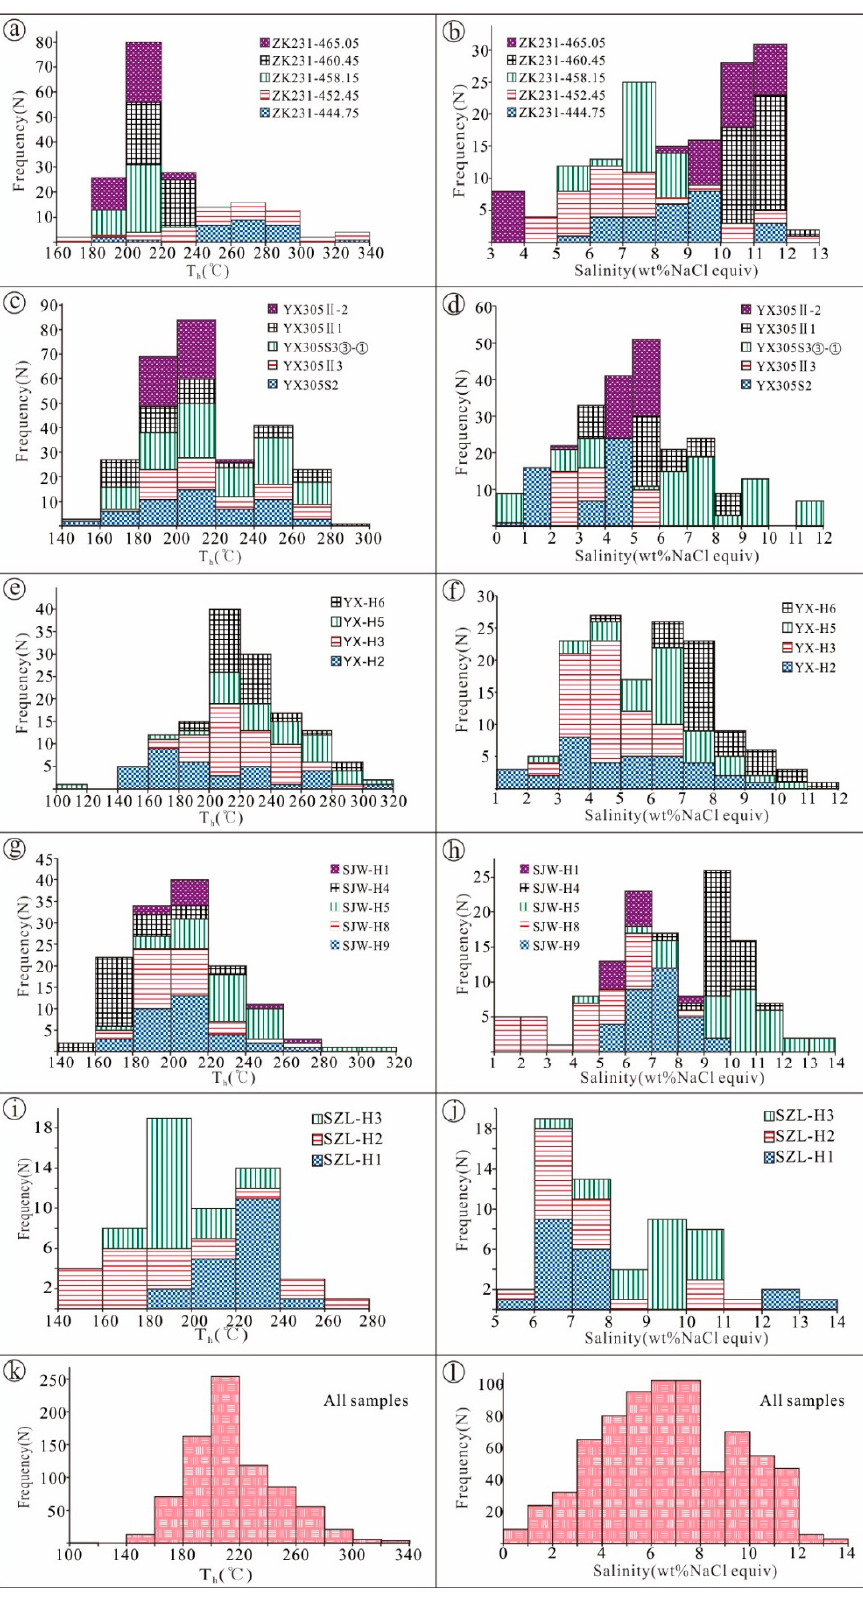
Figure 8. Histograms of homogenization temperatures and salinities of fluid inclusions in celestine in different types of ores ( a – j ) and all test results of fluid inclusions ( k , l ). See Figure 2 for sample locations and Table 2 for sample types.